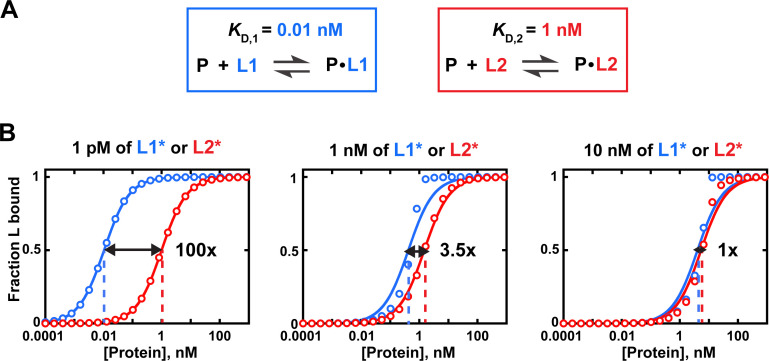
Effects of trace binding partner concentration on apparent relative affinities.(A) Affinities of protein P for ligands L1 and L2. (B) Simulated equilibrium binding curves. Binding to each ligand is measured individually with different concentrations of labeled ligand (L1* or L2*). Solid lines are fits to Eq. 4b, with dashed lines indicating the protein concentration at which half of the ligand is bound (corresponding to KD in Equation 4b). Arrows and numbers indicate apparent KD(rel) values at each concentration of L (KDapp(rel) = KD,2app/KD,1app; with KD,1app and KD,2app derived using Equation 4b). There is a pronounced dependence of apparent relative affinity on ligand concentration if [L] is not much lower than the KD for the most tightly bound ligand among the ligands being compared. If sufficiently low ligand concentrations are not accessible, Equation 5 should be used and results may be less reliable (see section 'Avoid the titration regime' of main text).